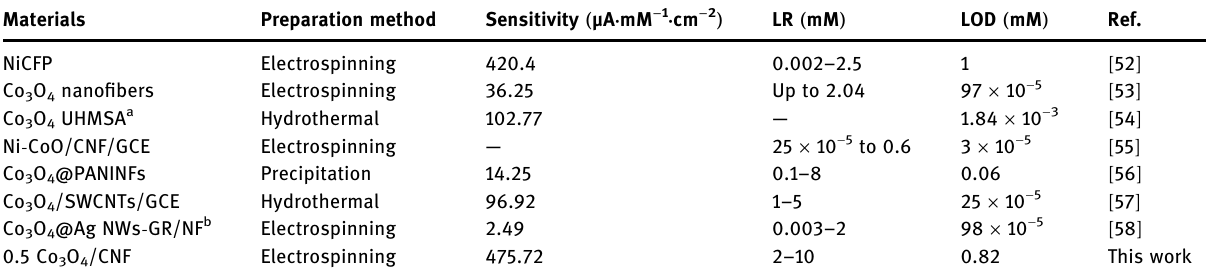
Table 3: The comparison between our work and recent reported nonenzymatic glucose biosensors Materials Preparation